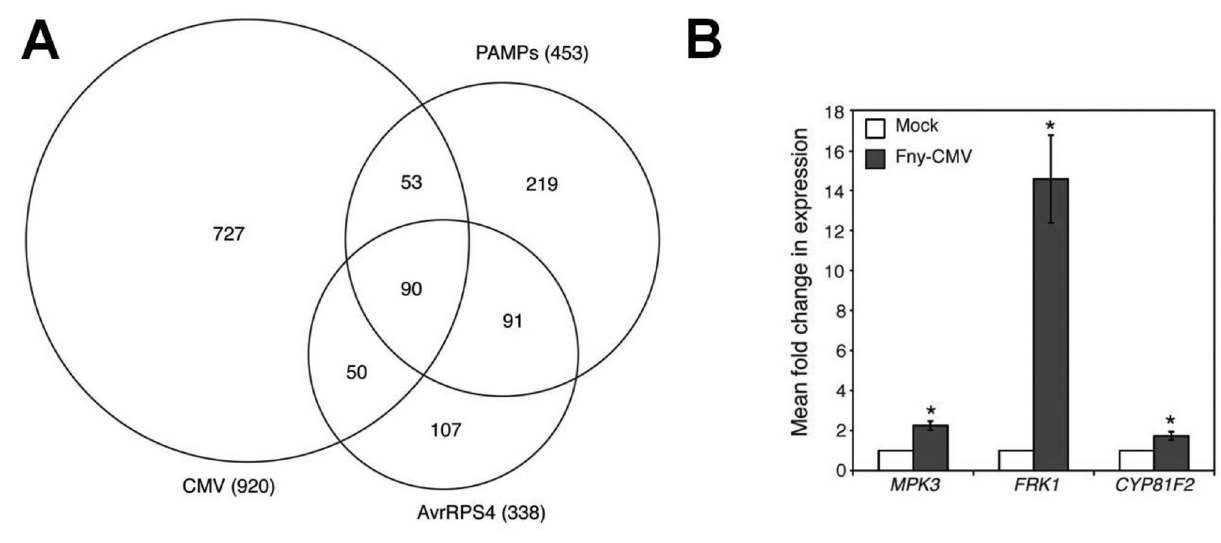
Figure 3. Fny-CMV infection of Arabidopsis induced genes that are also activated during PAMP- and effector-triggered immunity. (A) Area-proportional Venn diagram showing overlap between genes activated during PAMP- and effector-triggered immunity. Genes up-regulated by Fny-CMV infection were compared with previously published microarray data showing genes commonly induced by three PAMPs (flg22, elf26, and chitin) [84], and genes induced by the Pseudomonas syringae effector AvrRPS4 in RPS4 Col-0 Arabidopsis [85]. Venn diagram was drawn based on an image generated using a free online program (http://bioinforx.com/free/bxarrays/venndiagram.php). (B) Accumulation of the defense-related transcripts MPK3, FRK1 and CYP81F2 was induced following infection with Fny-CMV as measured by RT-Q-PCR. Error bars represent standard error of the mean. Asterisks indicate significant differences (Student’s t -test): *, P <0.05.